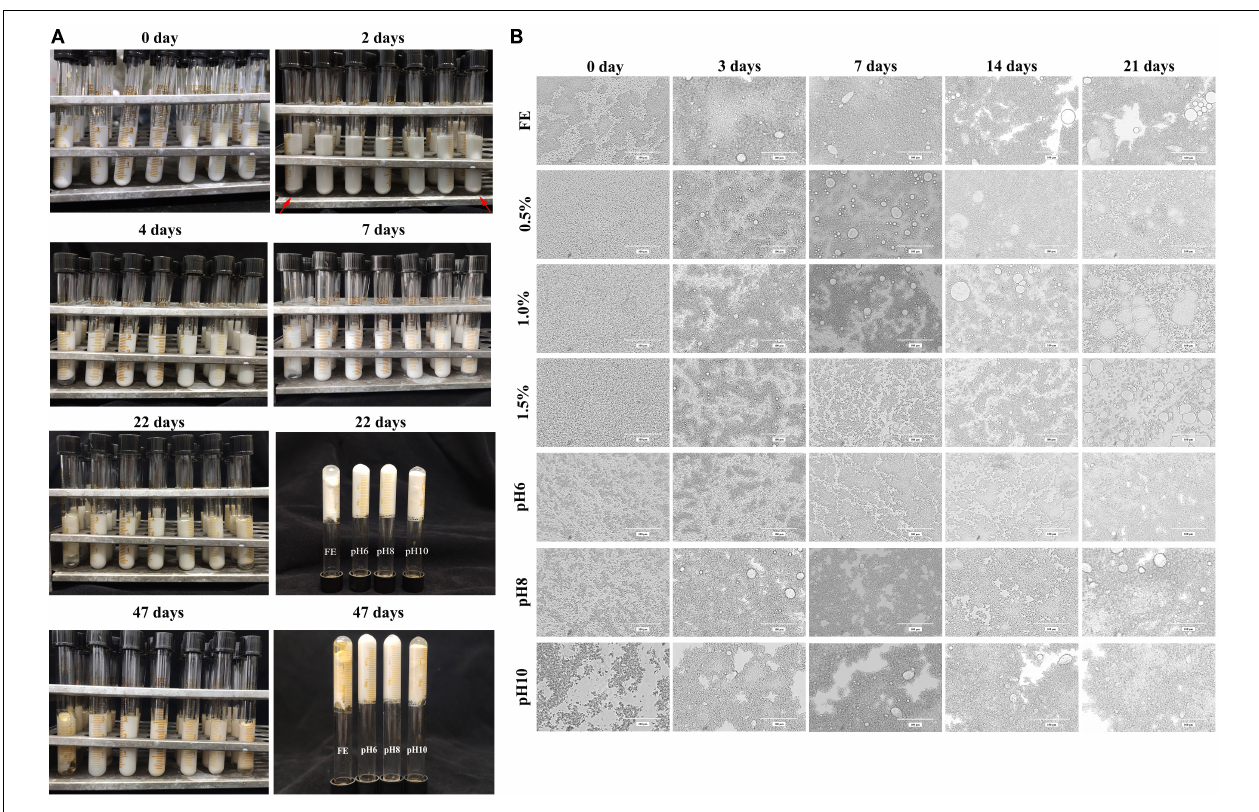
FIGURE 3 | Storage measurement (A) and optical microscope observations (B) of complex